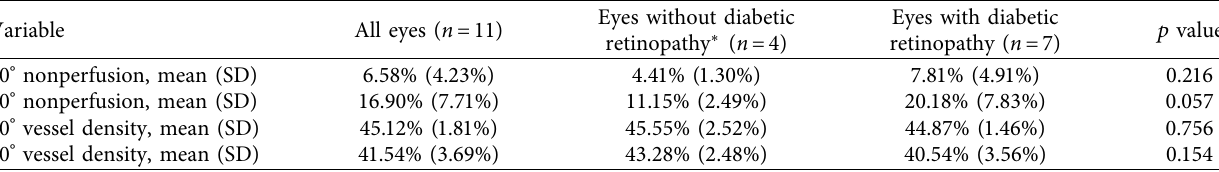
Table 2: Characteristics of 11 eyes examined with optical coherence tomography